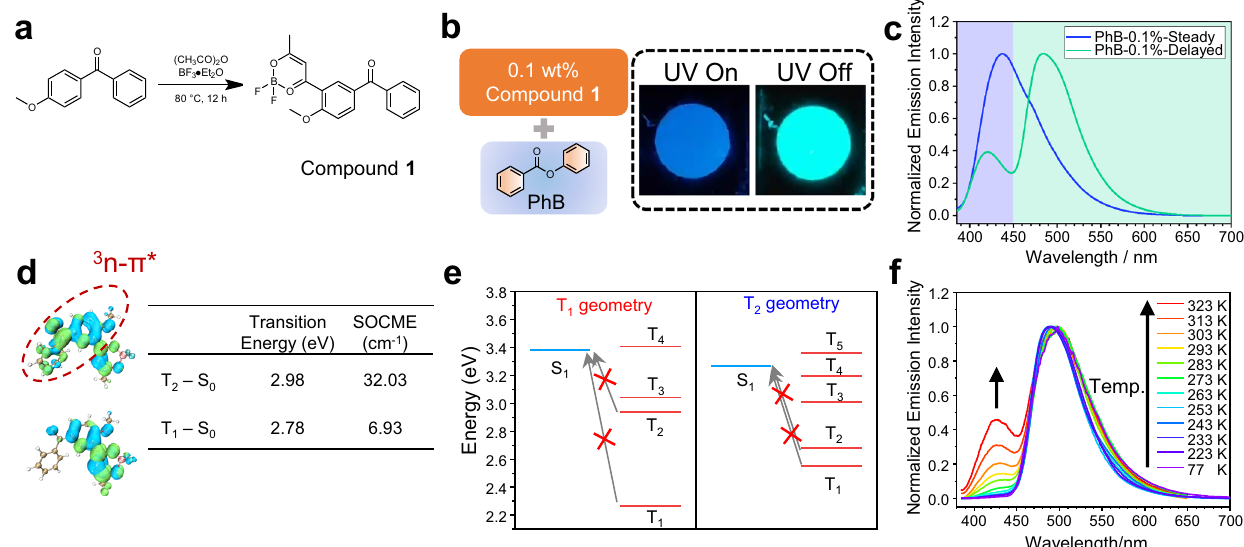
Fig. 1 | Photophysical properties of compound 1 system. a Cascade reaction for the synthesis of compound 1 ; b Illustration of the material composition and pho- tographs of 1 -PhB-0.1% under a 365 UV lamp and after removal of the UV lamp; c Normalized steady (blue line) and delayed (green line, 1ms delay) emission spectra for 1 -PhB-0.1% powder at room temperature; d TD-DFT calculation results of T 1 and T 2 states of compound 1 based on optimized S 0 geometry: the isosurface mapsofelectron-holedensitydifference(blueandgreenisosurfacescorrespondto